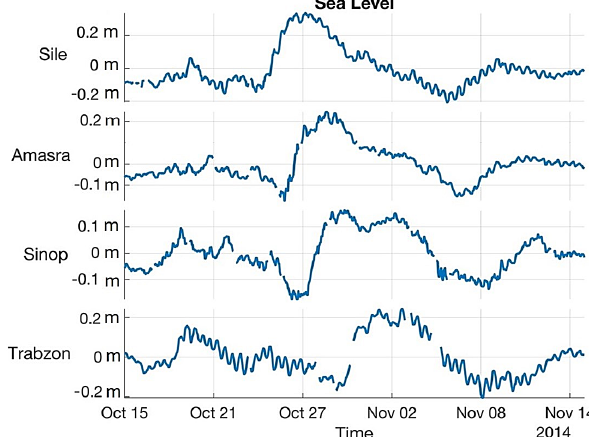
Figure 5. Time series of the sea level variations from 15 October to 15 November 2014. The data were subsampled from Fig. 2. The data have been smoothed using the robust linear regression method of the MATLAB smoothdata function with the rlowess option.